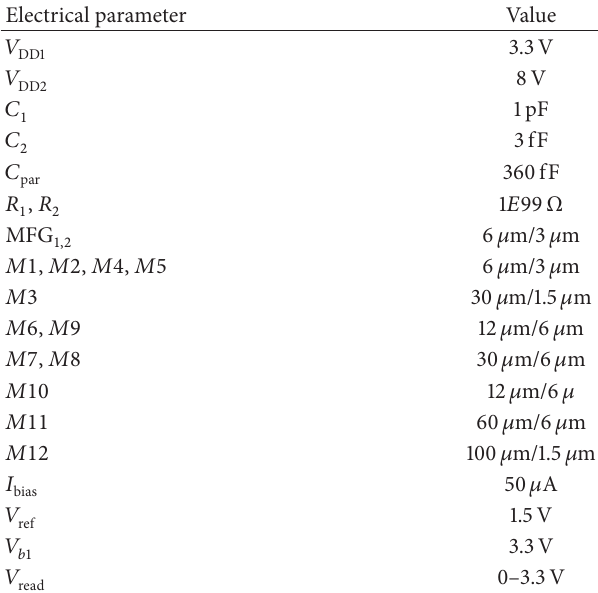
Table 1: Electrical values for the memory